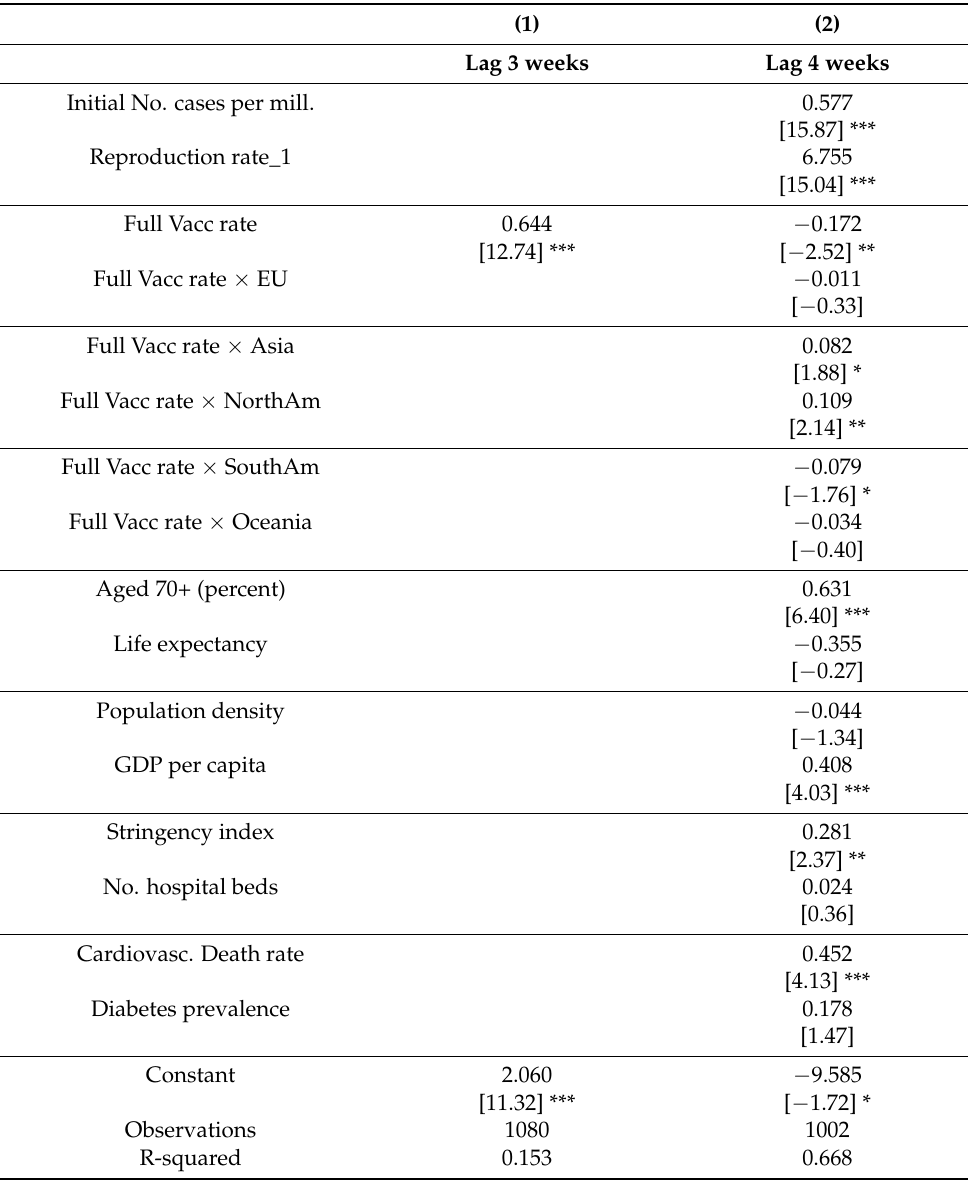
Table A2. Impact of vaccination rate on number of new COVID cases. (1) (2) Lag 3 weeks Lag 4 weeks Initial No. cases per mill.